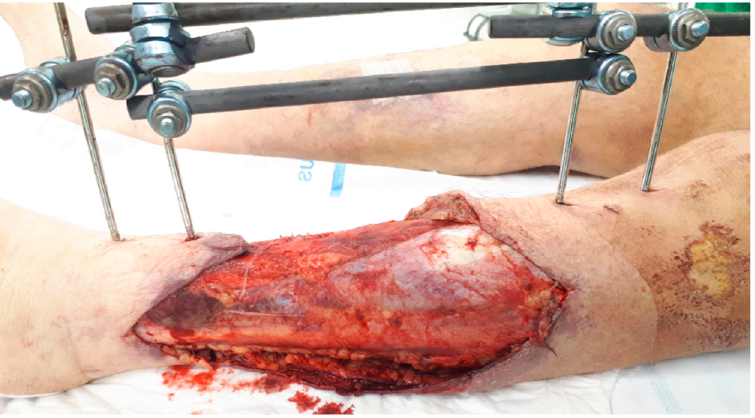
Figure 1. Clinical image of the bifocal Gustilo-Anderson type IIIB open tibia and fibula fracture, temporarily managed by external fixation (status on the fifth day after trauma).